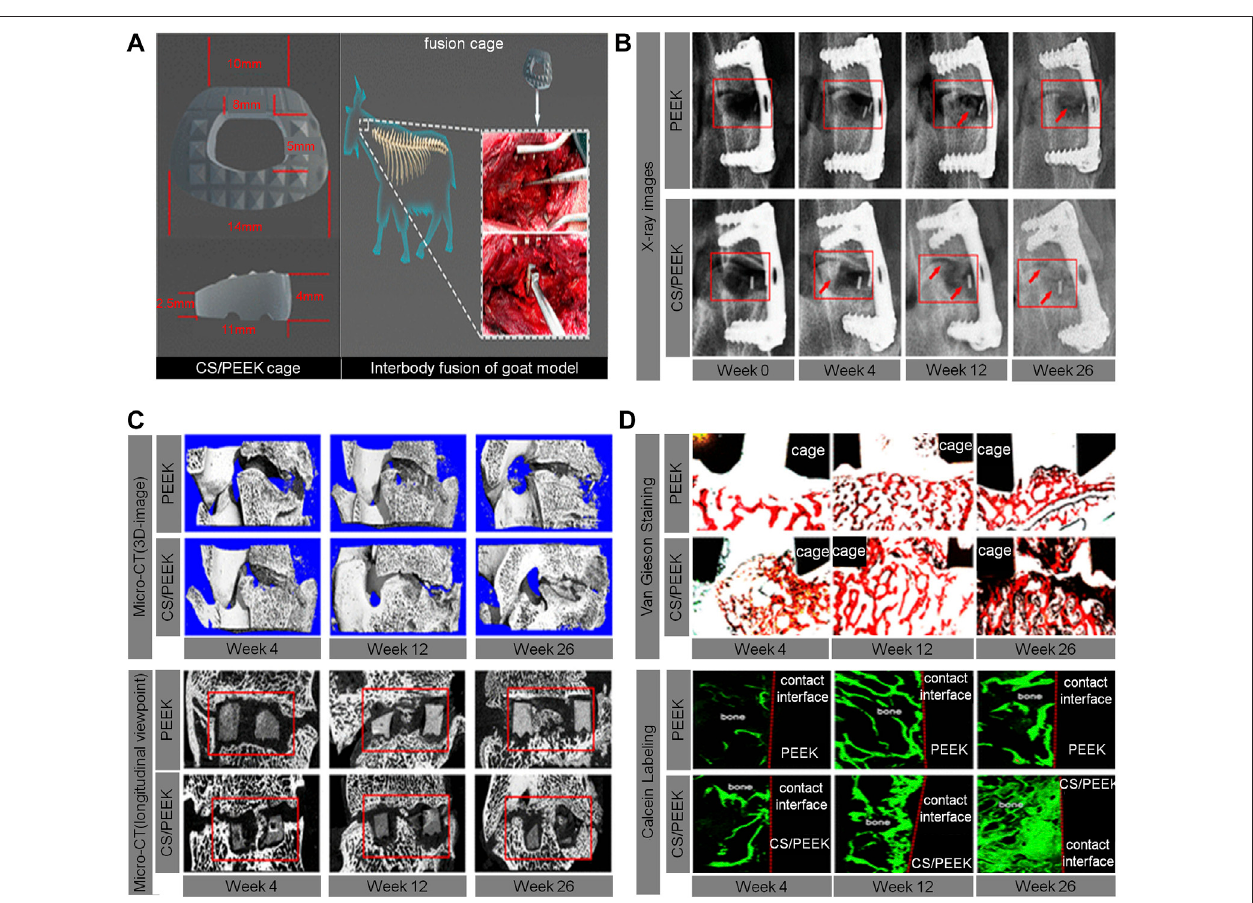
FIGURE4|(A) ThesizeandimplantationoftheCS/PEEKcageinagoatinterbody fusionmodel. (B) Interbodyfusionat0,4,12,and26 weeksbasedontheX-ray observation; representative X-ray images with red arrows indicate the bone ingrowth. (C) 3D and longitudinal images of the interbody fusion of bone formation in the interbody fusion at 4, 12, and 26 weeks based on the micro-CT scans. (D) Analysis of osseointegration at 4, 12, and 26 weeks based on histological assessment, including Van Gieson staining and fl uorescence labeling by calcein (Chu et al., 2019).